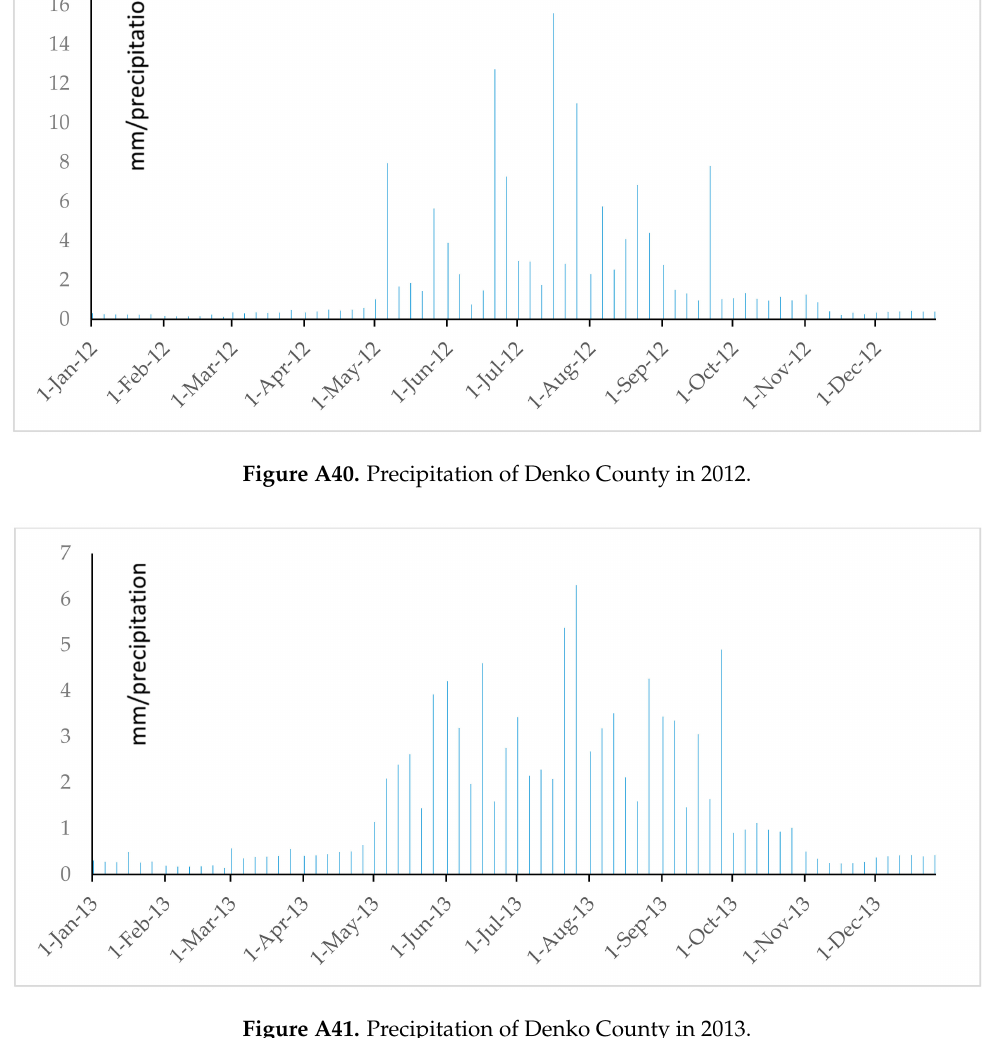
Figure A41. Precipitation of Denko County in 2013.